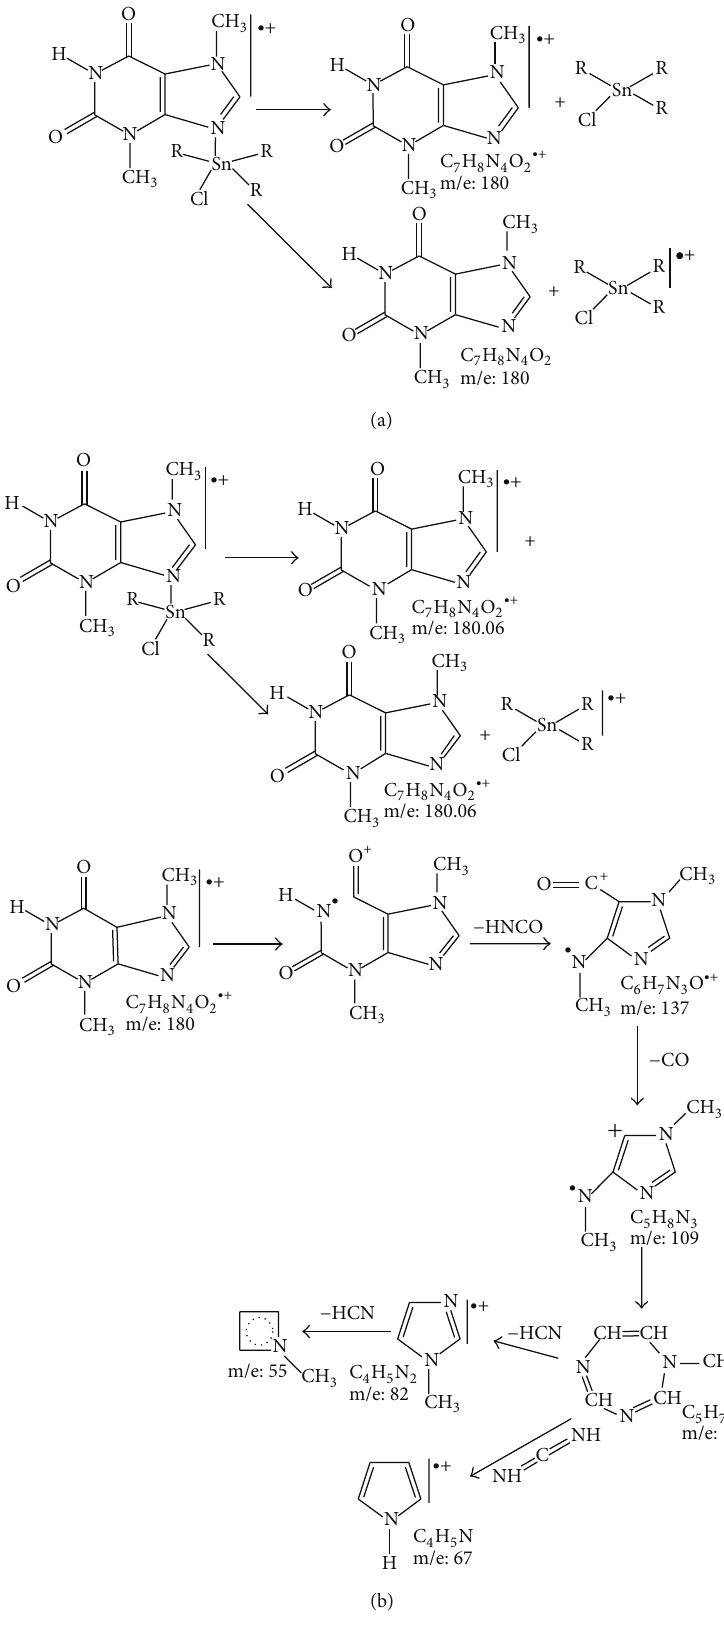
Scheme 2: Fragmentation pattern for theobromine